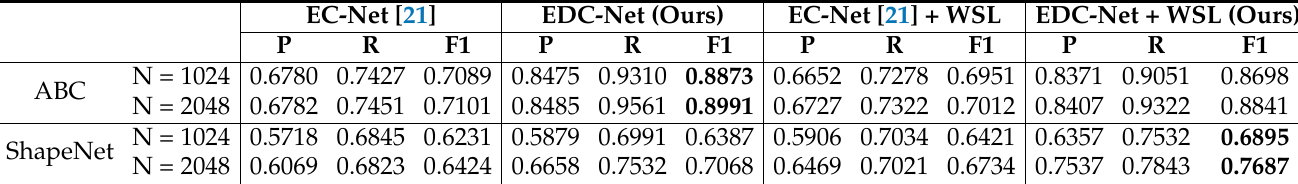
Table 1. Results on ABC [35] and ShapeNet [34] samples. WSL stands for weakly-supervised learning. P and R are represented for precision and recall respectively. The highest F 1 score at each line is shown in bold. EC-Net [21] EDC-Net (Ours) EC-Net [21] + WSL EDC-Net + WSL (Ours) P R F1 P R F1 P R F1 P R F1 N = 1024 0.6780 0.7427 0.7089 0.8475 0.9310 0.8873 0.6652 0.7278 0.6951 0.8371 0.9051 ABC